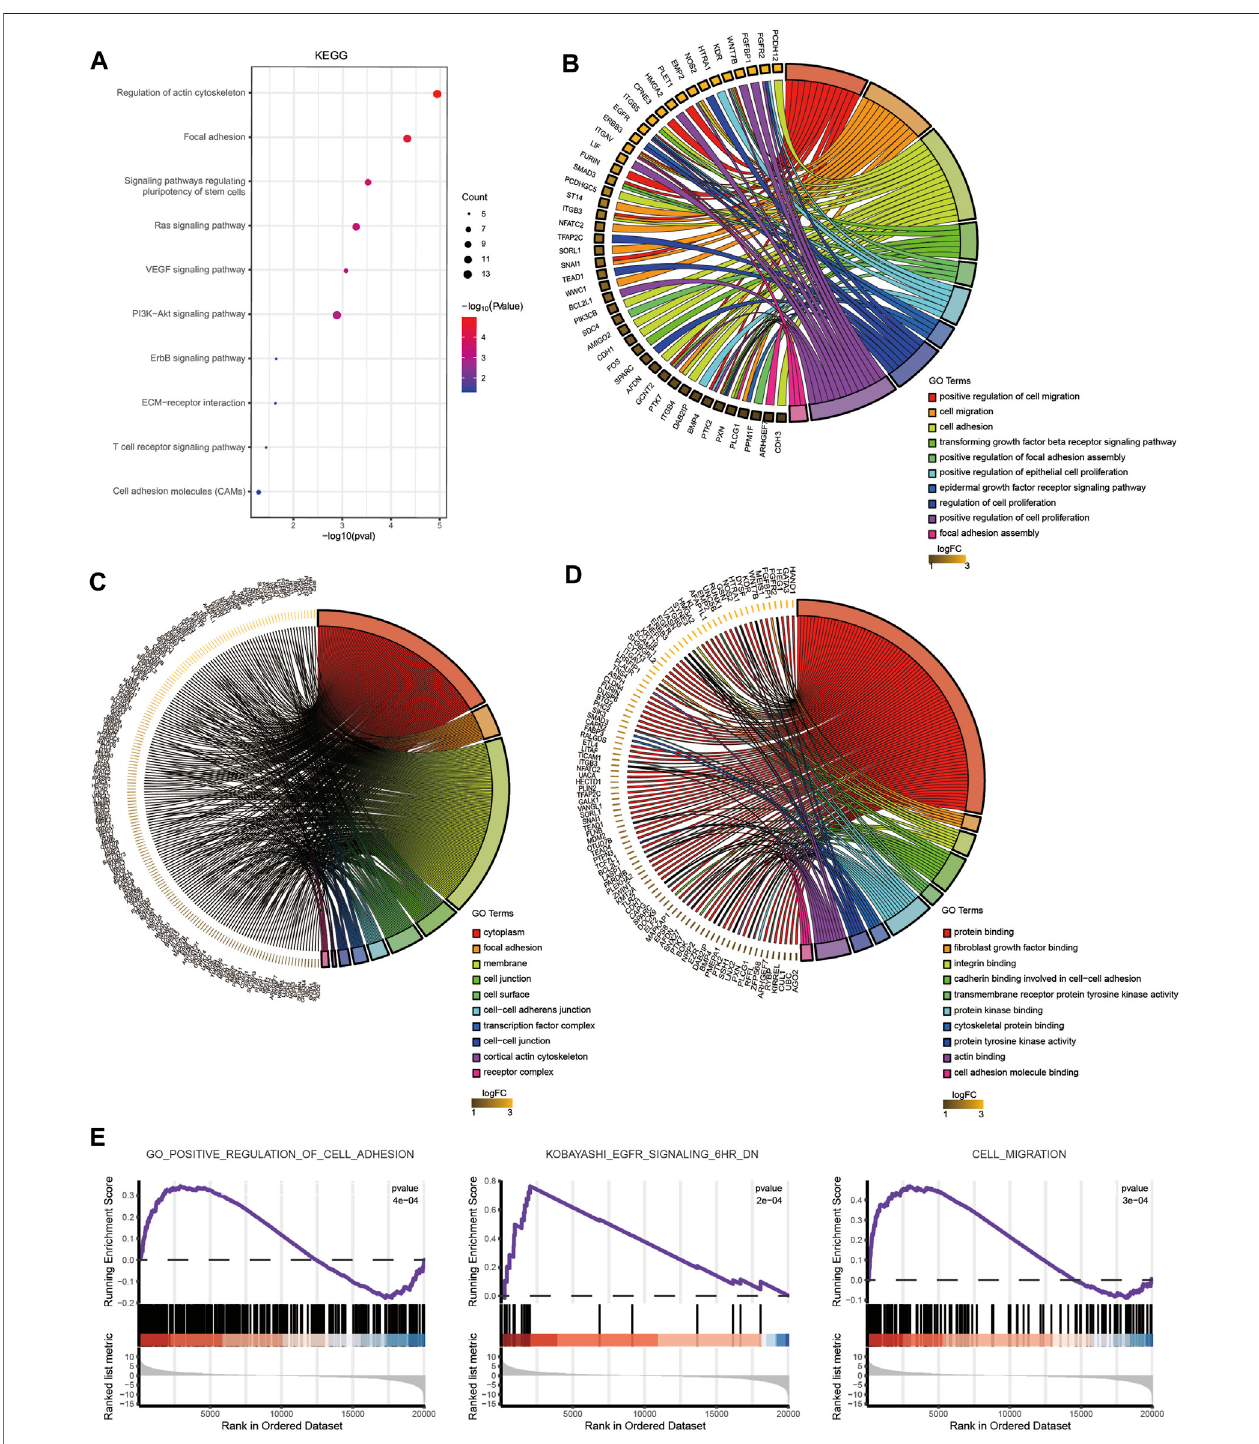
FIGURE4| EnrichmentanalysisofTSC-SEs. (A) KEGGpathwayenrichmentanalysisofupregulatedgenestargetedbyTSC-SEs. (B) GO_BPpathwayenrichment analysis of TSC-SEs. (C) GO_CC pathway enrichment analysis of TSC-SEs. (D) GO_MF pathway enrichment analysis of TSC-SEs. (E) Gene set enrichment analysis of TSC-SEs.